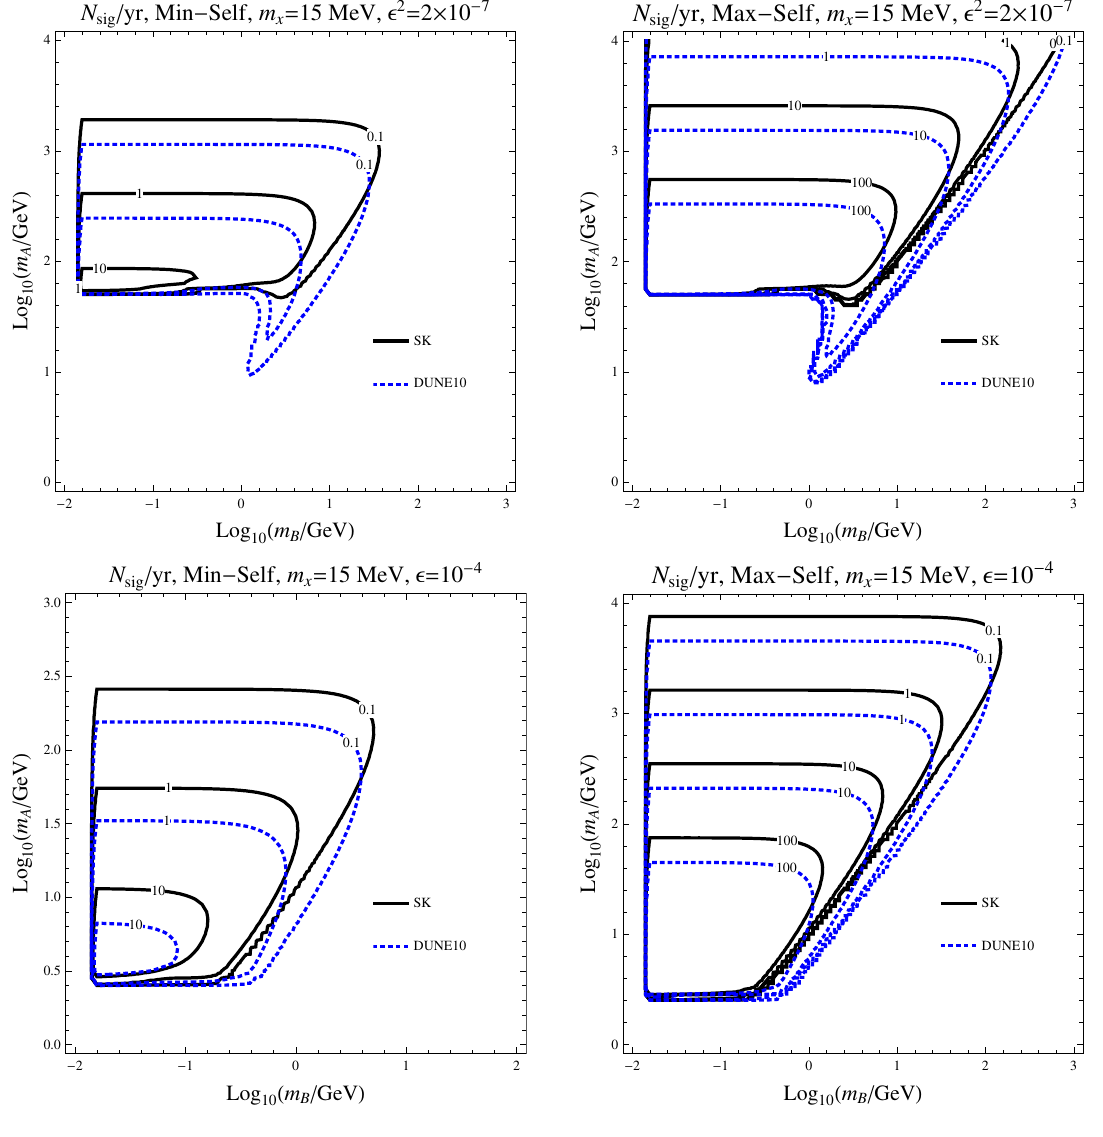
Figure 3 . The number of signal events per year at SK and DUNE 10 for (cid:15) 2 = 2 in the top (bottom) panel for Min (Max) SI in the left-panel (right-panel). Using eq. (5.4), we calculate the expected number of signal events per year at SK and DUNE 10, which are respectively shown as solid-black and dotted-blue contours in (cid:12)gure 3 for (cid:15) 2 = 2 10 (cid:0) 7 ( (cid:15) = 10 (cid:0) 4 ) in the top (bottom) panel 8 and for Min (Max) SI of A (cid:2) in the left-panel (right-panel). Here Min (Max) SI is (cid:27) AA =m A = 0 : 1 (1 : 25) cm 2 = g. The interesting shape of the constant number of signal events is well studied in ref. [18]. The boundary in the left side is set by m B > m X where m X = 15 MeV in our benchmark point (log ( m X = GeV) 1 : 82). The top edge is a(cid:11)ected by the DM number density 10 (cid:25) (cid:0)